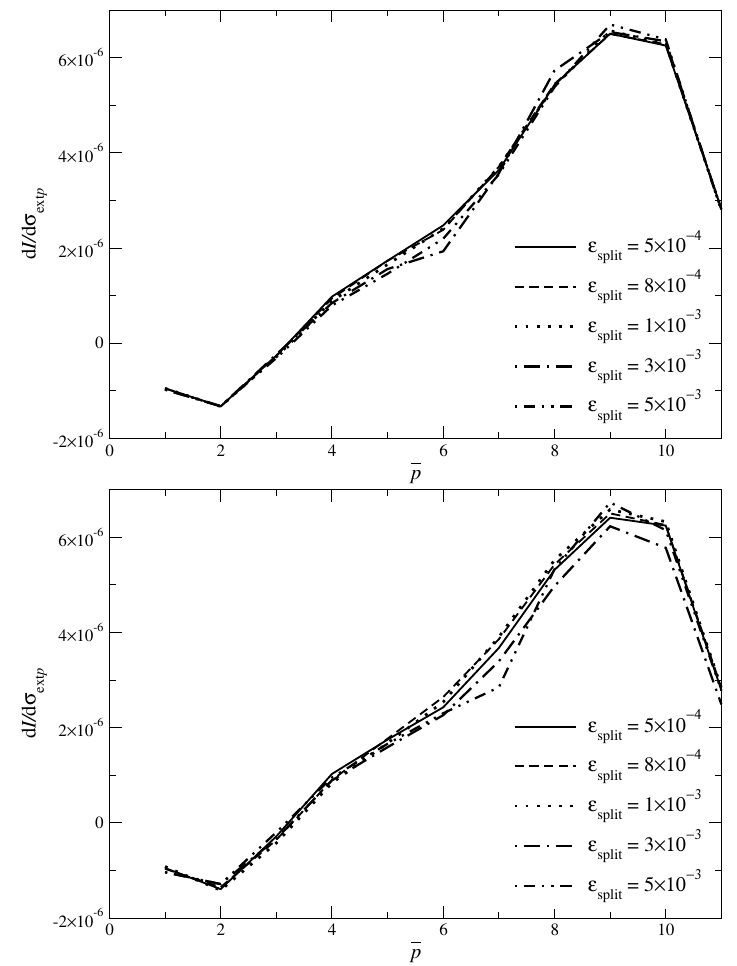
y = y 0 z = p ∆ z ), p = 1,...,11, t , t ,